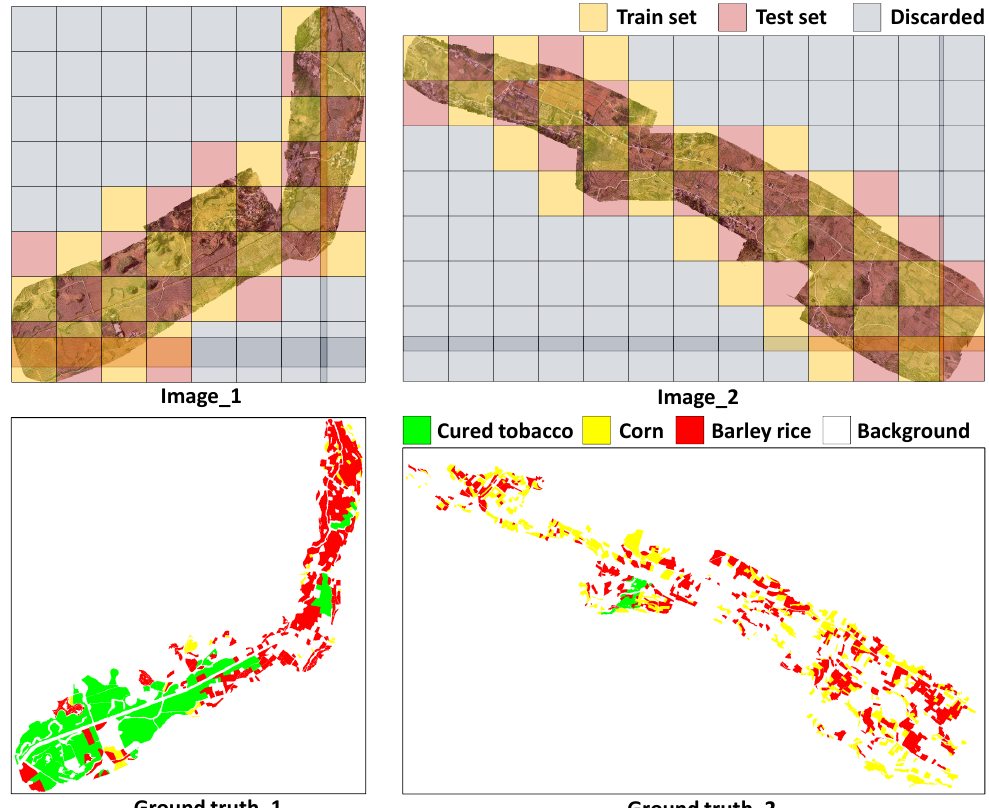
Figure 10. Display of the Barley Remote Sensing Dataset.